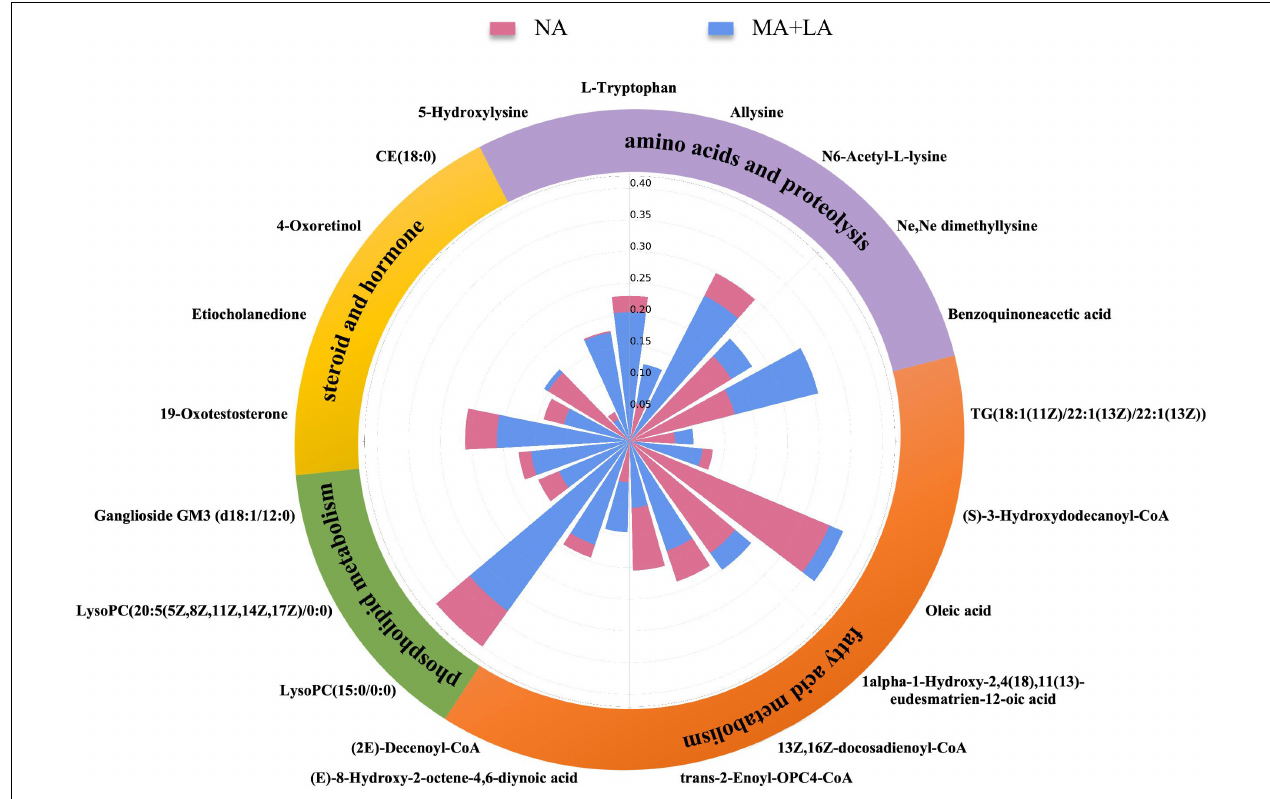
FIGURE 3 | Use of metabolic fingerprints to unravel underlying pathophysiological changes during the progression of ascites. The Nightingale rose diagram of ascites-related metabolic fingerprints. The value of the relative intensity of each metabolite was normalized within the two groups. The whole set of metabolites in the fingerprint was classified into different metabolic pathways, including fatty acid metabolism, phospholipid metabolism, steroids and hormones, amino acids, and